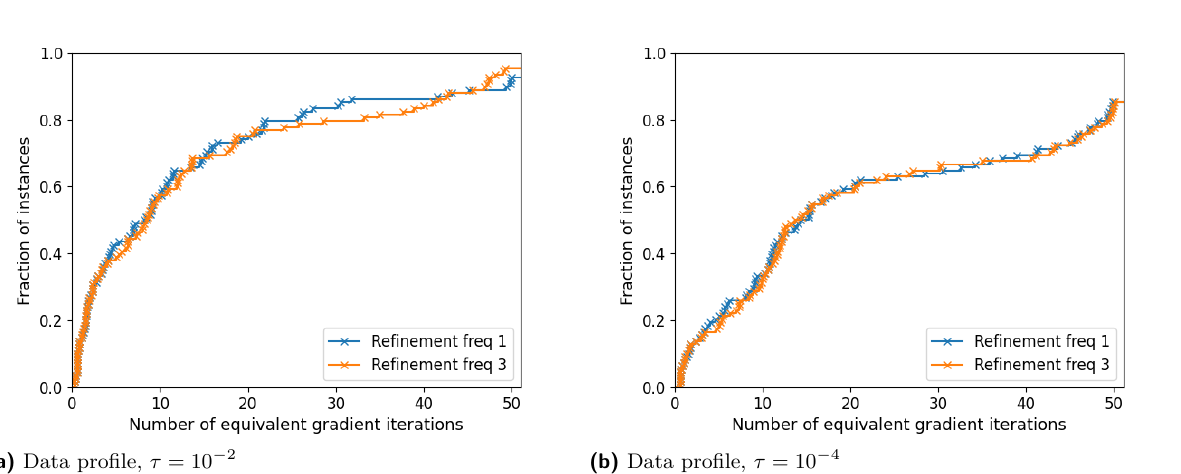
Figure 4 Data profiles with different frequencies of the Refinement